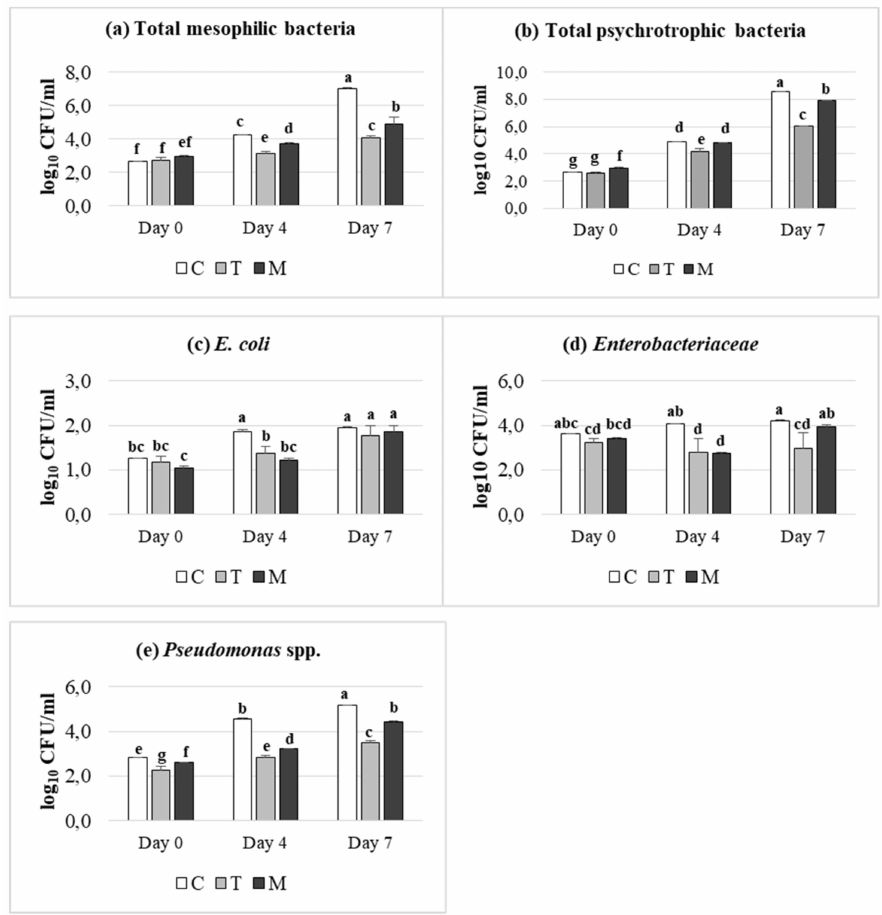
Figure 1. E ff ect of dietary treatment (Control (C), Tara (T) or Mimosa (M)) and time of storage (days 0, 4 and 7) on microbial counts expressed as log10 CFU / mL: ( a ) total mesophilic bacteria; ( b ) total psychrotrophic bacteria; ( c ) E. coli ; ( d ) Enterobacteriaceae ; ( e ) Pseudomonas spp. a – g : Values with di ff erent superscripts are significantly di ff erent ( p ≤